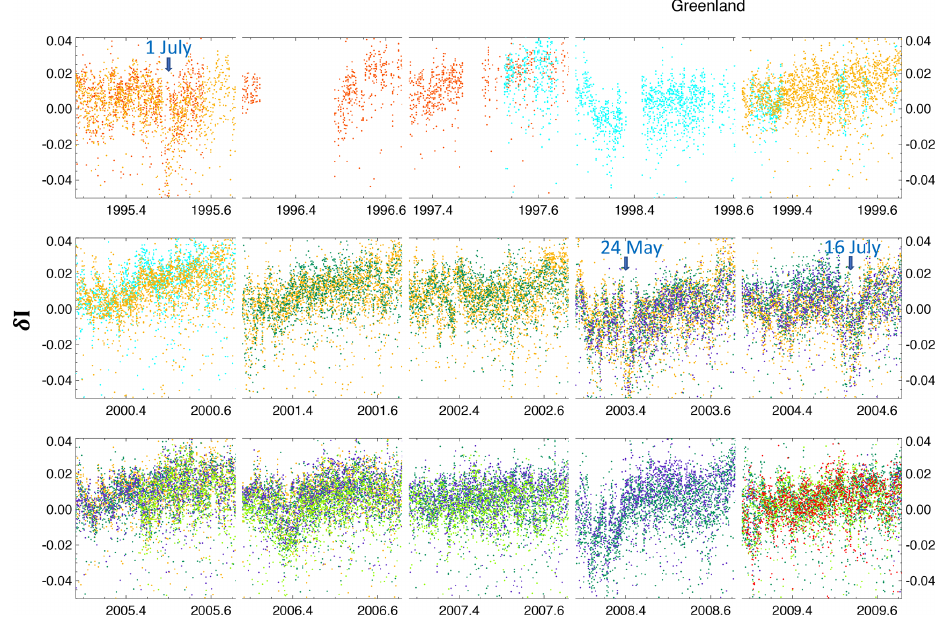
Figure 7. Time series of empirically calibrated δI for all FOVs observed over Greenland for selected years. Blue arrows indicate estimated dates when CO from boreal forest fires reaches Greenland (see text). The color scheme is the same as the other